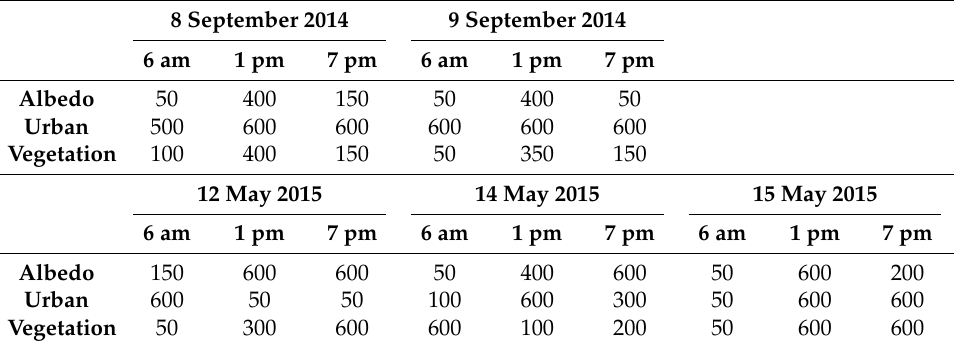
Table 3. Buffer sizes for each variable (in